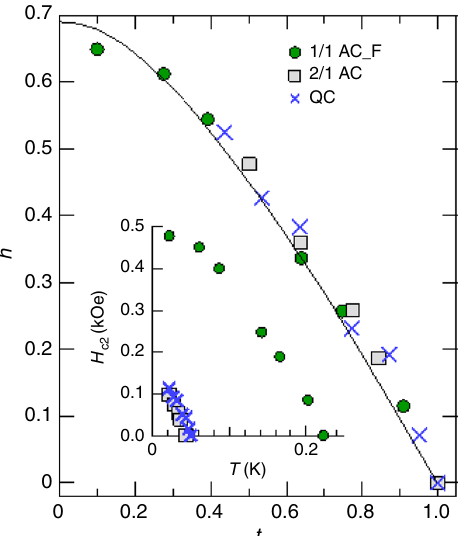
Fig. 10 Superconducting upper critical fi eld. The superconducting upper critical fi elds H c2 of the QC, the 2/1AC, the 1/1AC_F are plotted in the